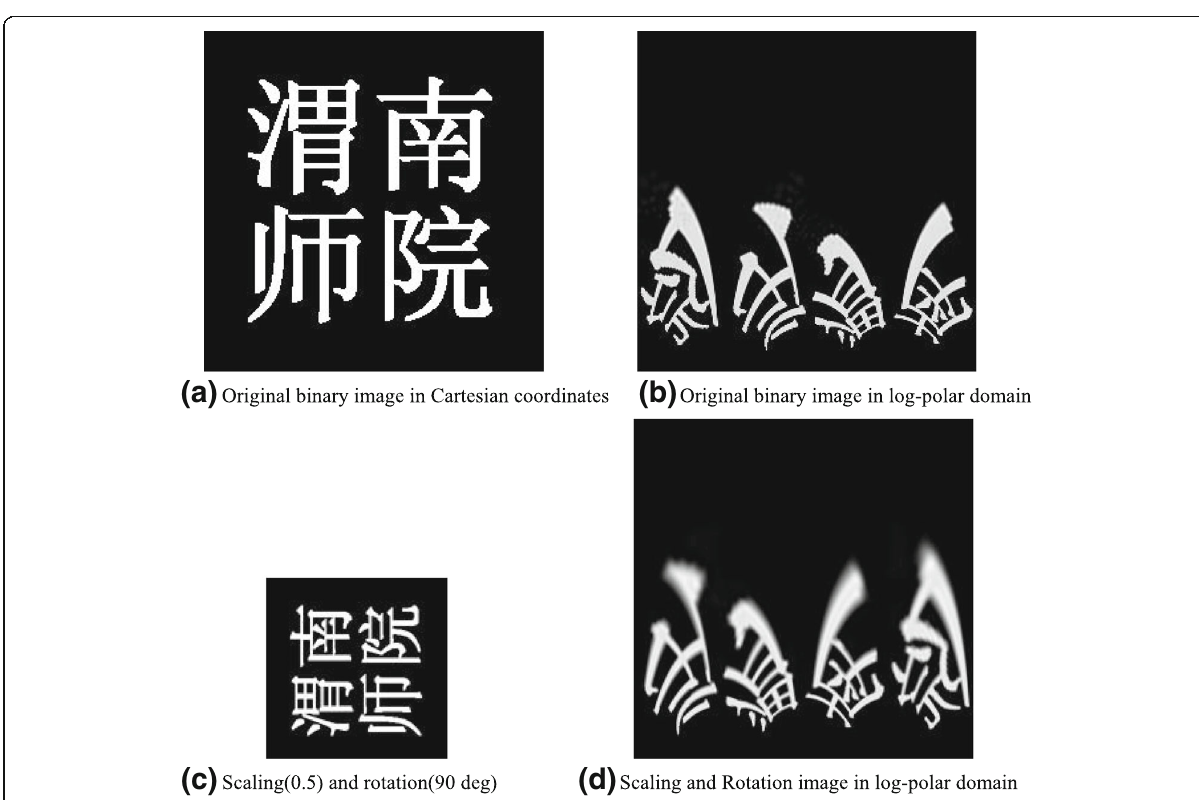
Fig. 13 The original binary image and the scaled and rotation image in Cartesian coordinates and Log-polar coordinates respectively. a Original binary image in Cartesian coordinates. b Original binary image in log-polar domain. c Scaling(0.5) and rotation(90 deg). d Scaling and Rotation image in log-polar